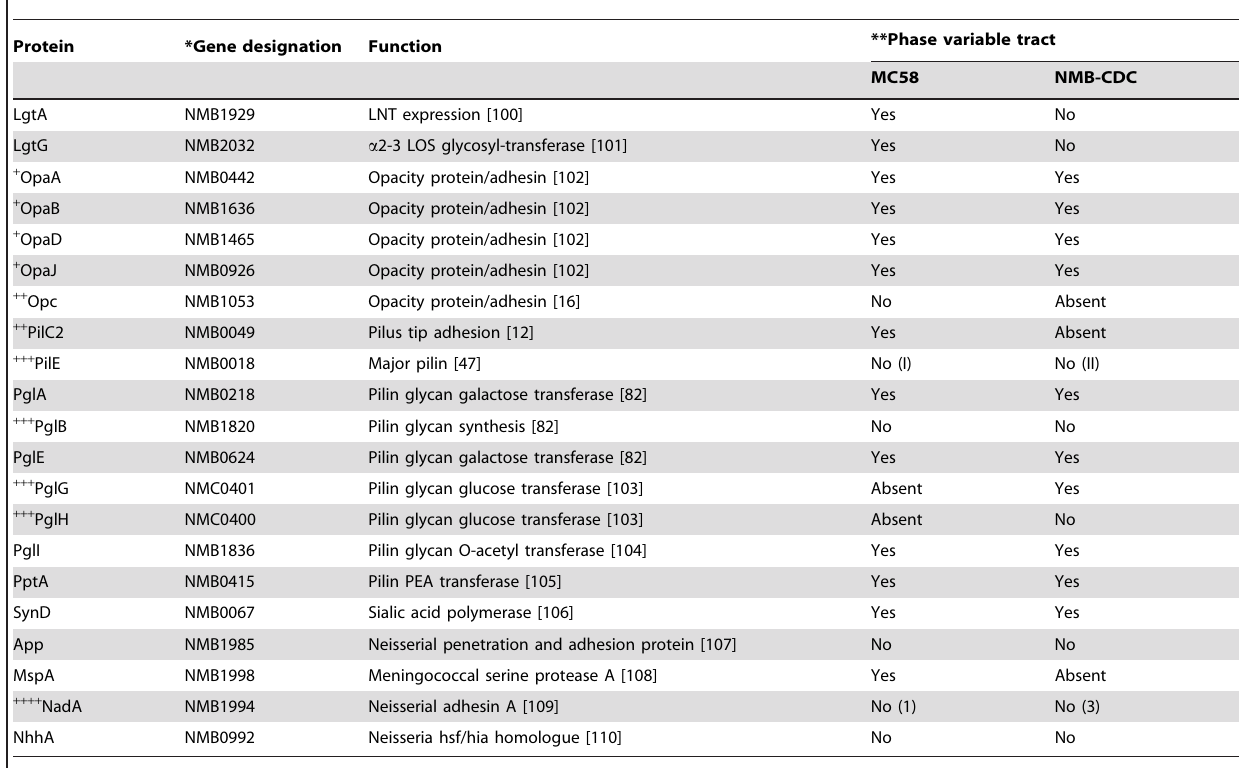
Table 3. A comparison of virulence encoding genes between strains NMB-CDC and MC58.